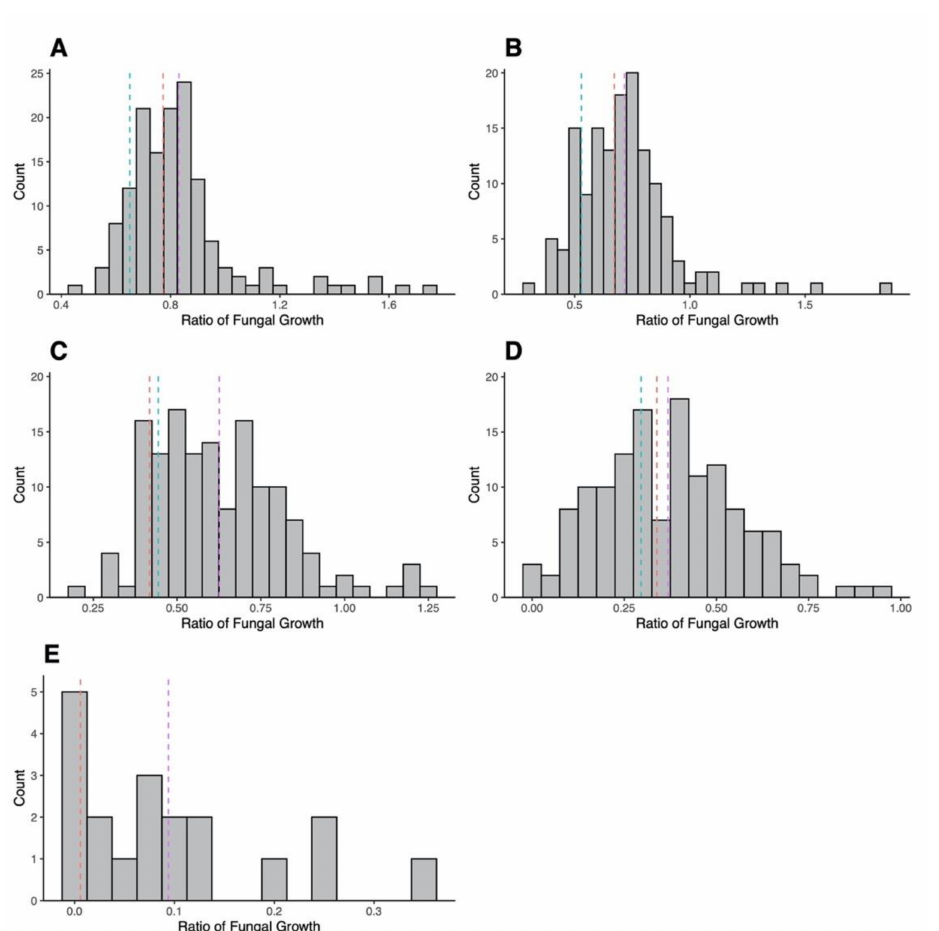
Figure 2. Distribution of growth ratio values for the progeny strains measured at Amphotericin B concentrations of ( A ) 0.25 mg/L ( n = 143), ( B ) 0.50 mg/L ( n = 143), ( C ) 1.00 mg/L ( n = 143), ( D ) 2.00 mg/L ( n = 139), and ( E ) 4.00 mg/L ( n = 19). Fungal growth was determined by calculating difference in OD 530 at start (0 h) and end of incubation (48 h); this value was divided by fungal growth in the positive control (0 mg/L) to determine the ratio of fungal growth. Dashed lines represent the values of the two parental strains, CM11 (red) and AFB62-1 (blue), as well as the mean value for the progeny